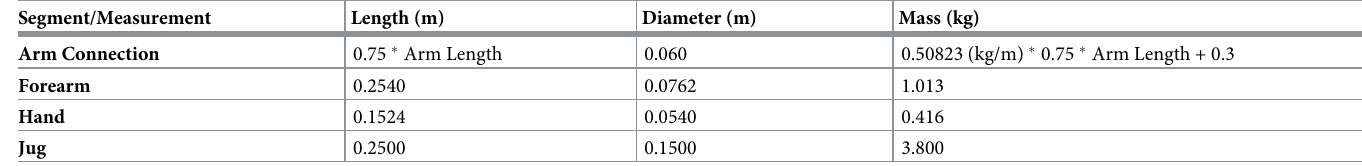
Table 1. Dimensions and masses of the segments constituting the prosthesis system model utilized for inverse